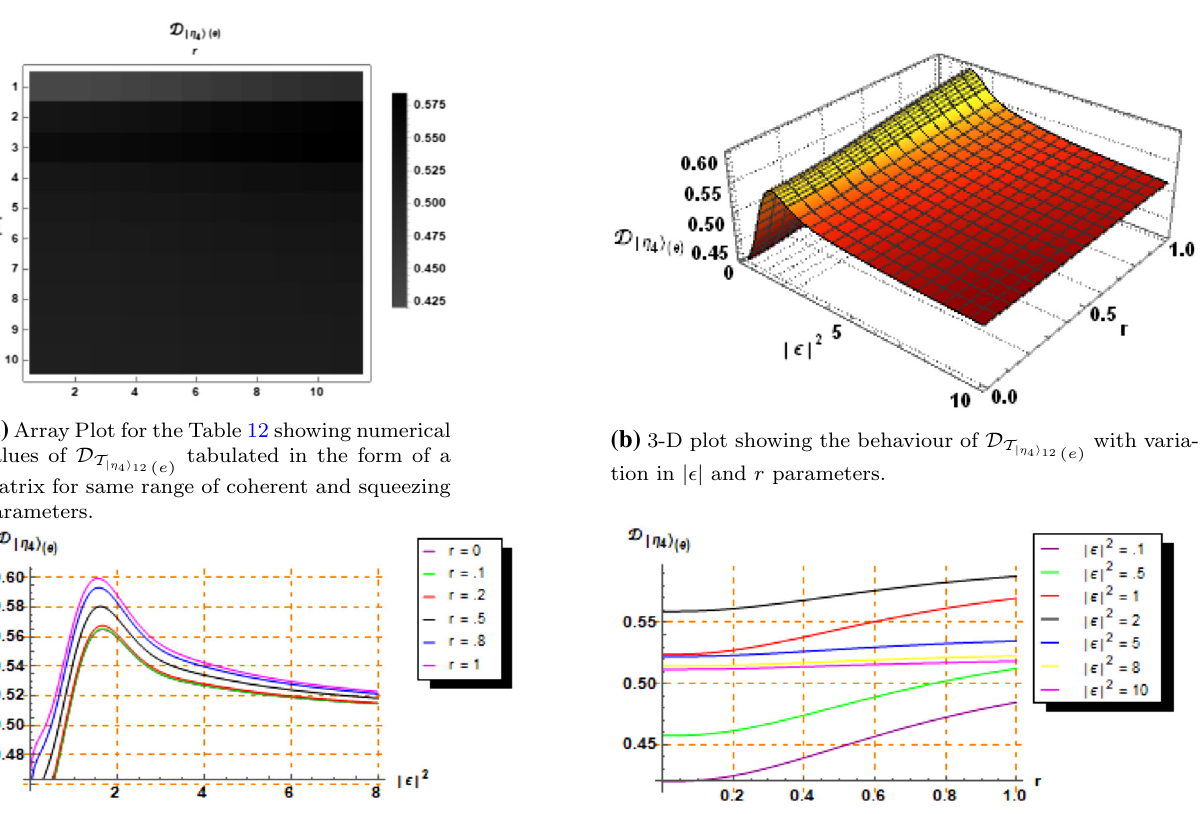
tion in | (cid:2) | and r parameters.